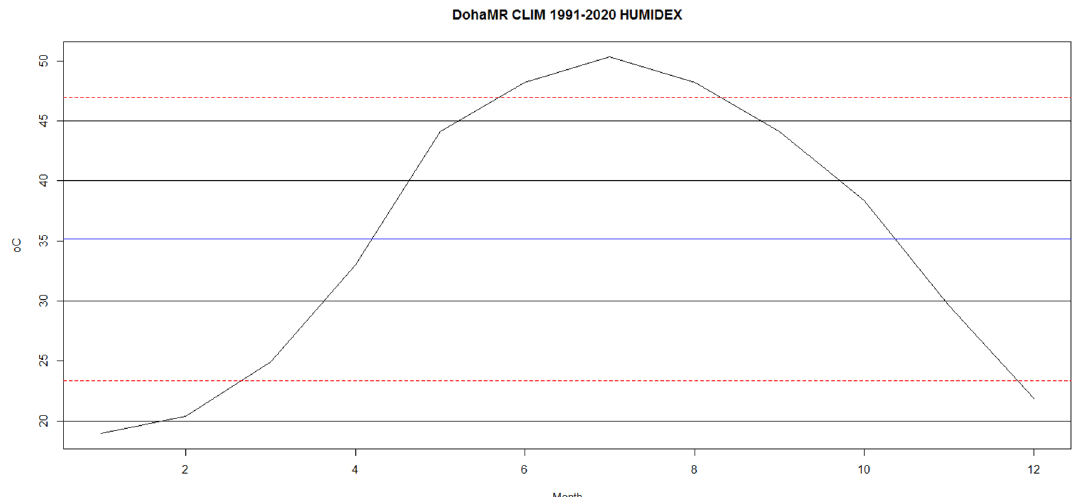
average and the red dashed line is the standard deviation-based interval, and the solid lines are the thresholds established in the lit- erature